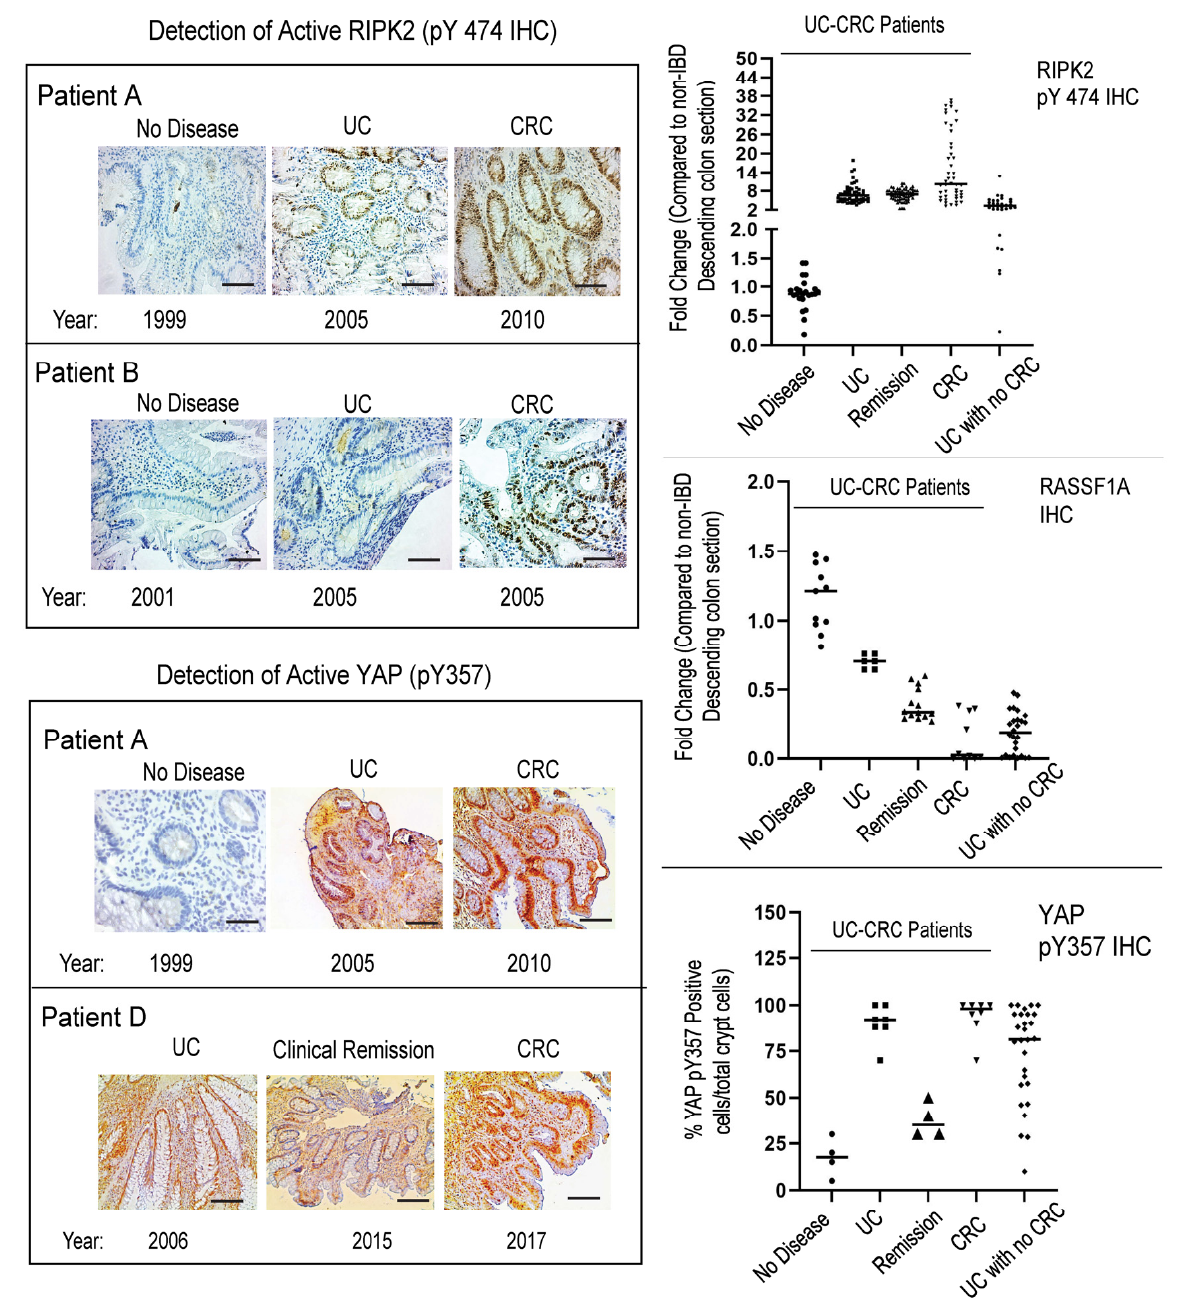
Figure 7. Immunohistochemical staining for RASSF1A, RIPK2 pY474, and YAP pY357 in five patients with UC-CRC. Included in this panel is stage of disease and year diagnosed. Patients B and D have since passed away, of CRC-related disease. ( Left panel ), representative sections for each category are shown; ( Right panel ), summary of fold changes for each biomarker explored. For RIPK2, p value < 0.0001 between UC and UC with no CRC, p value = 0.75 for difference between UC and UC in remission, and p value < 0.0001 between UC and CRC (n = 40–60 sections). For RASSF1A, p value < 0.0001 between UC and UC with no CRC, p value < 0.0001 for difference between UC and UC in remission, and p value < 0.0001 between UC and CRC (n = 10–15 sections). For YAP pY357, p value < 0.0001 between UC and UC with no CRC, p value < 0.0001 for difference between UC